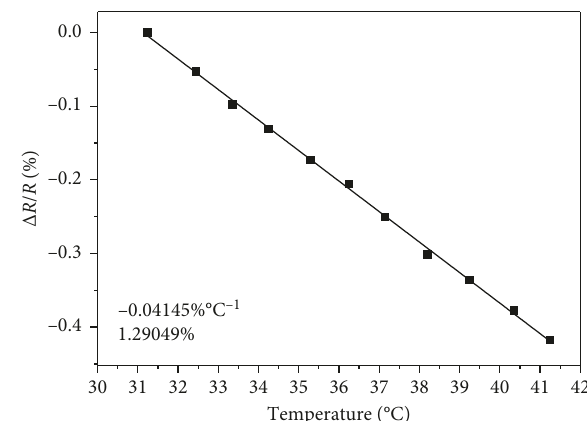
Figure 4: Linear relationship between the temperature and the LIG sensor resistance between 30 ° C and 40 ° C.